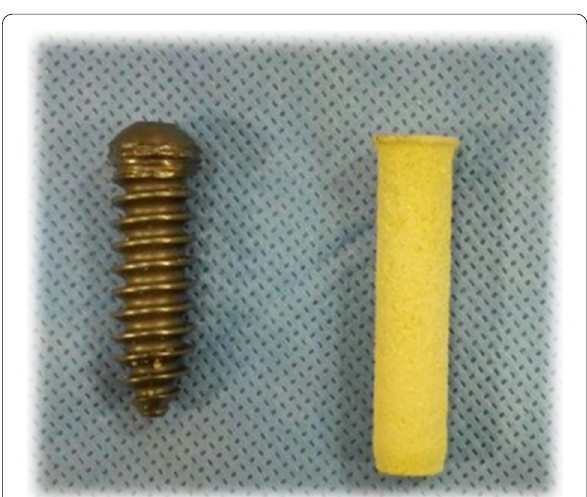
Fig. 4 RCI metal screw which is used for fixation in the tests and their size in comparison with a bone